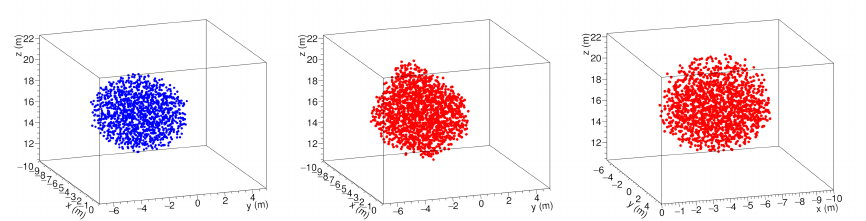
Figure 5. A spherical cavity ( left ) and its 3D reconstruction as seen from the observation point of the detectors C ( center ) and B ( right ) as in